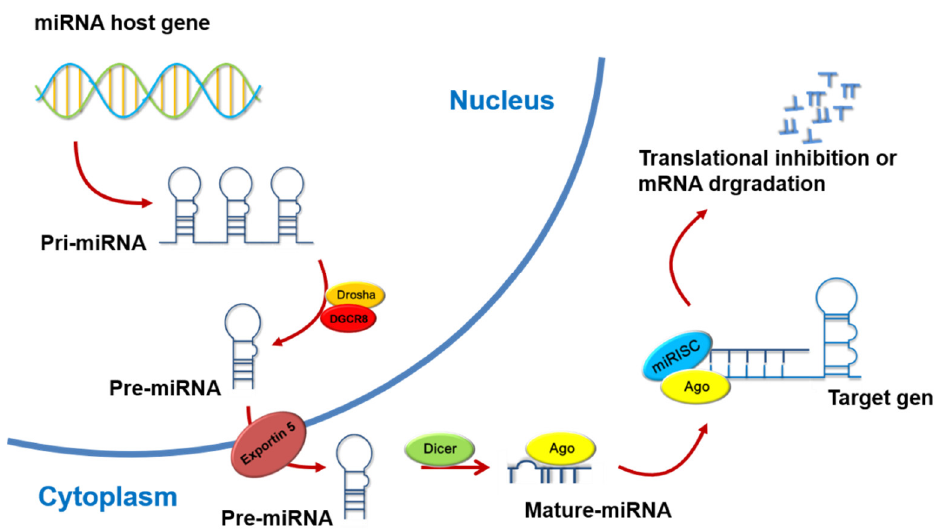
Figure 1. The biosynthesis and action mechanisms of microRNA.